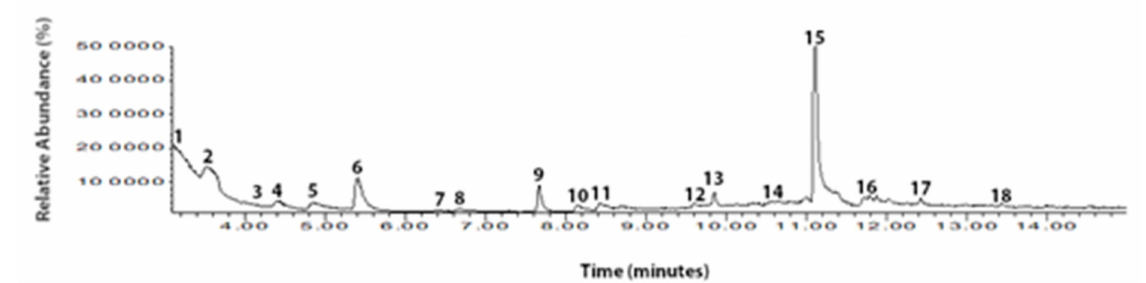
Figure 8. Total ion chromatogram of the VOCs and chemical composition in F-MC made with milk from Holstein cows. Chemical composition of CTF by HS-SPME/GC-MS with retention time (rt) :